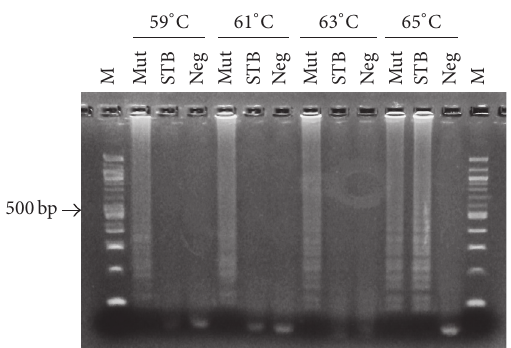
Figure 2: Determining the optimal temperature for LAMP. Lanes 1 and 14 (M): Ladder DNA marker; Lanes 2–13: reaction for 60 min at 59, 61, 63, and 65 ∘ C; Mut as MDR-TB; STB as H37RV; Neg as negative. All LAMP products were electrophoresed on 2% agarose gels and stained with MaestroSafe Nucleic Acid Gel Stain Sample (Maestrogen).